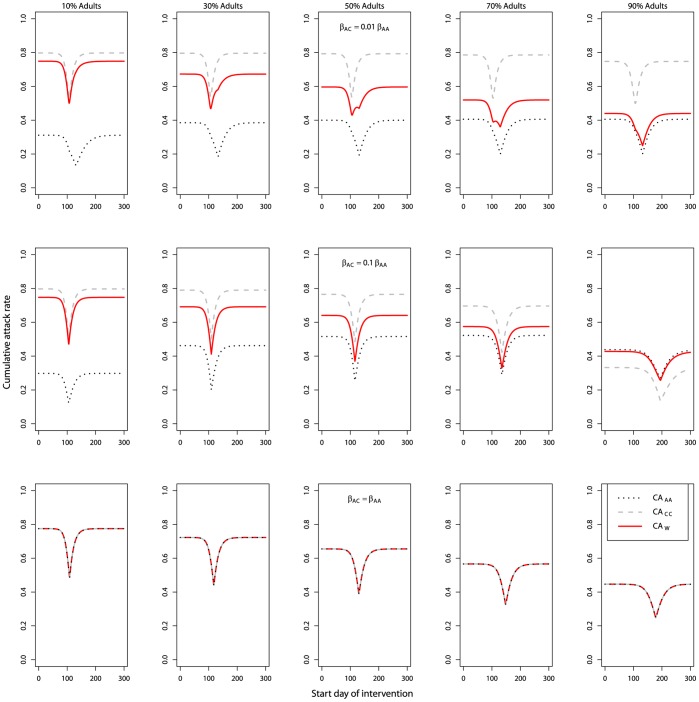
Cumulative attack rates against the start day of intervention in the presence of inter-group transmission.Transmission between adults and children was 1% of intra-group transmission (βAC = 0.01 * βAA; βCA = 0.01 * βCC; upper row), or 10% (βAC = 0.1 * βAA; βCA = 0.1 * βCC; middle row), or 100% (βAC = βAA; βCA = βCC; lower row). The fraction of adults in the population was (from left to right) 10%, 30%, 50%, 70%, and 90%. Black dotted line: adults (CAAA); grey broken line: children (CACC); red solid line: whole population (CAW). Like the no-coupling scenario, the CAW curve shifted lower if there were more adults and higher if there were more children. In the lower panels, all three lines overlap with each other. R0A = 1.25, R0C = 2; 50% adults; 50% children; long intervention; interrupt all routes of transmission; intervention efficacy, fAA = fAC = fCA = fCC = 1. All other parameters and initial conditions are listed in Tables 1 and 2.